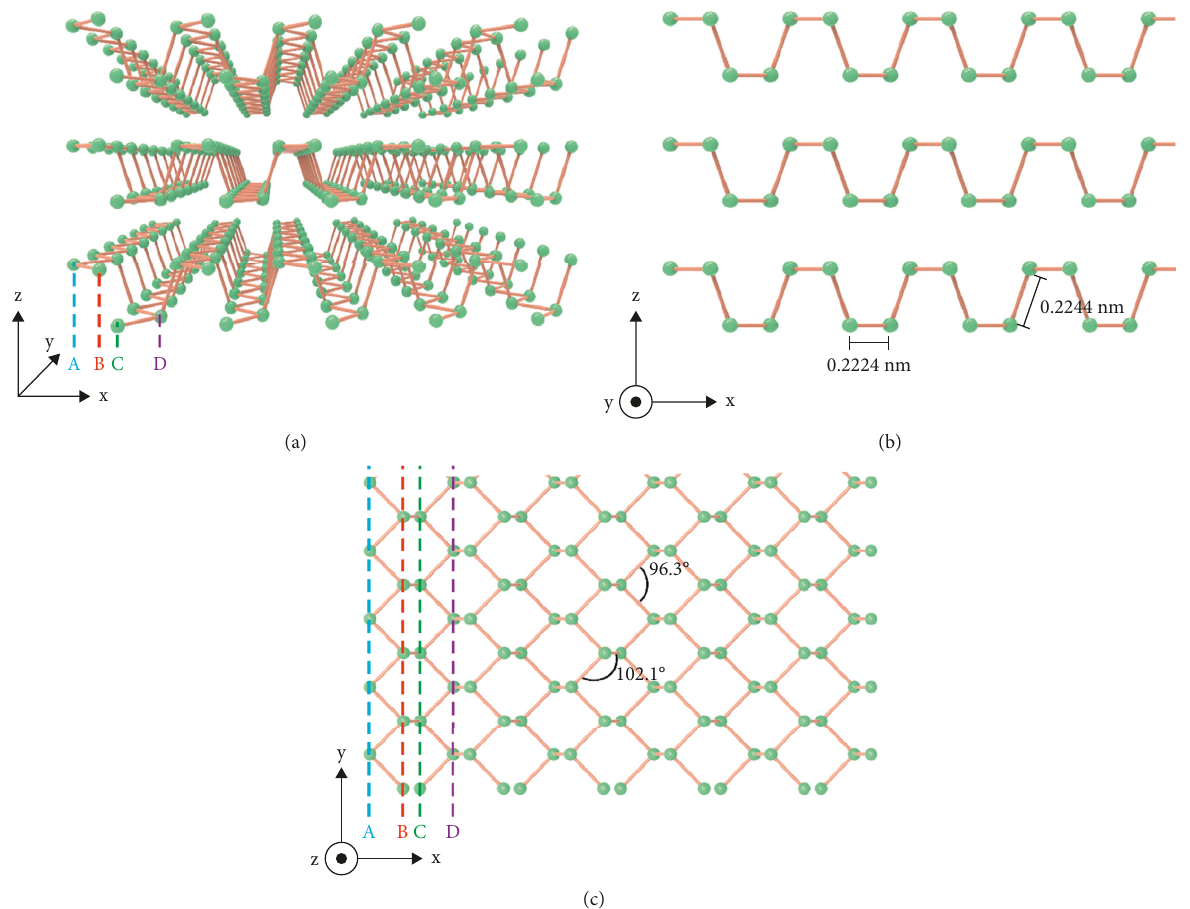
Figure 2: The structure of BP. Abbreviations: (a) the 3D structure of BP; (b) the lateral view of BP; (c) the top view of BP; x armchair; y zigzag.